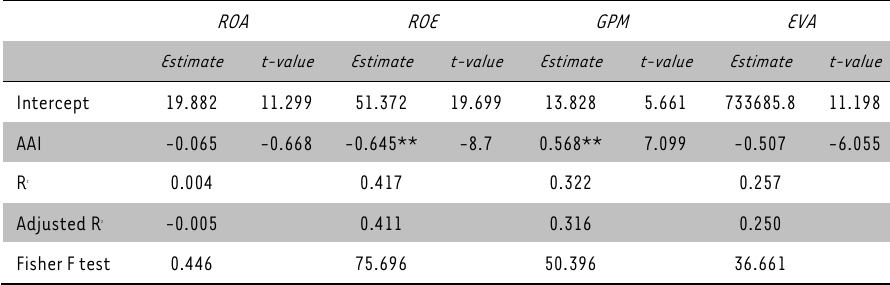
TABLE 4: Multiple regression analyses between AAI and profitability ROA ROE GPM